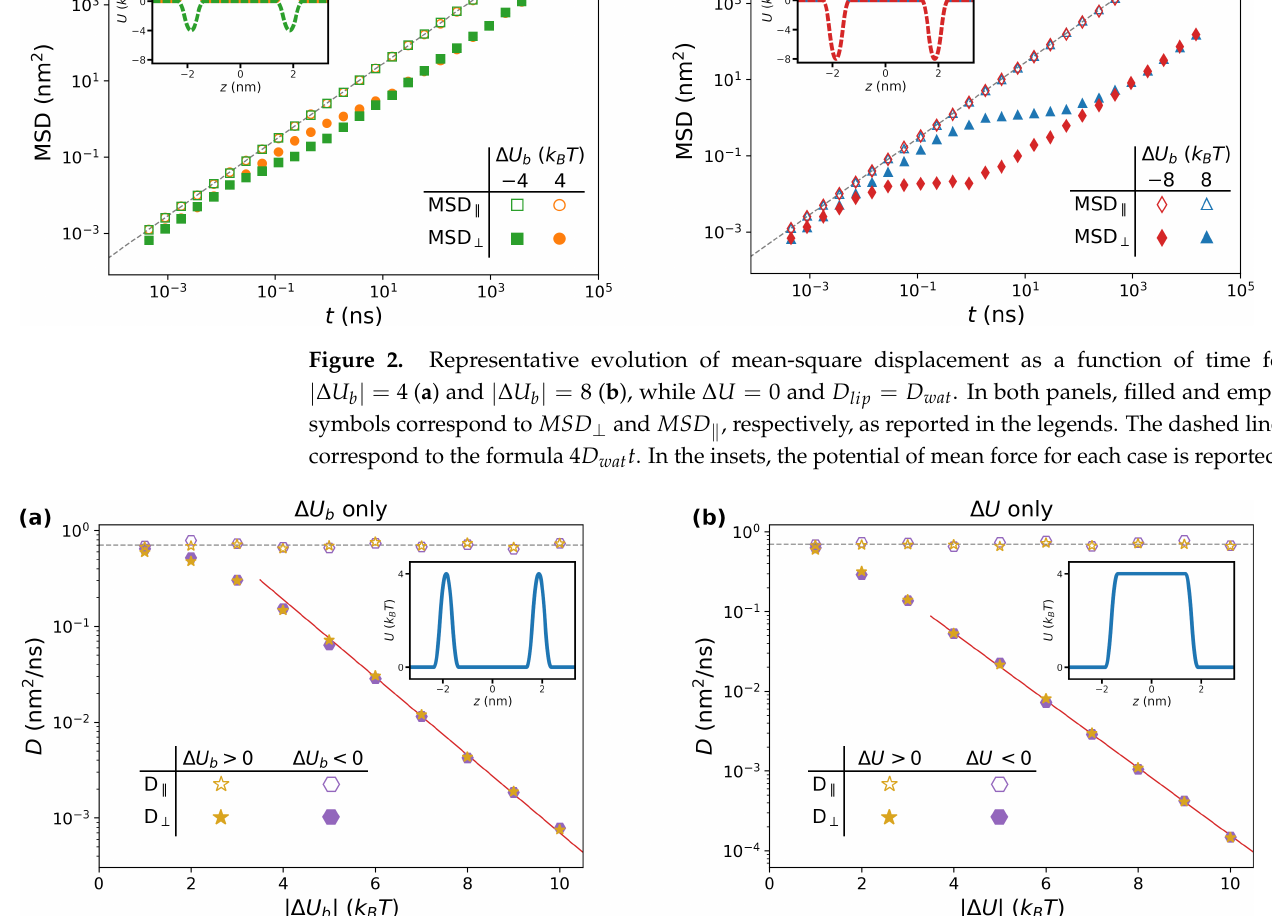
∆ U | in systems with ∆ U = 0 and D = D wat . b lip